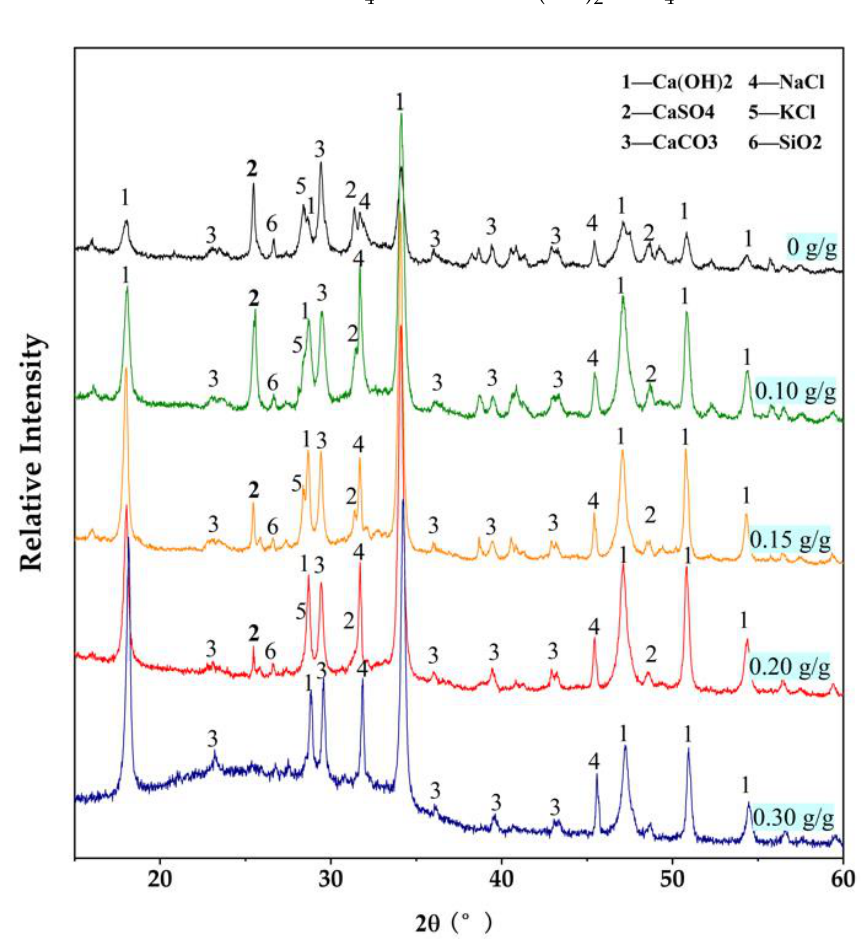
Figure 5. XRD patterns of ashes upgraded by water washing and alkaline washing (L/S = 6 mL/g).